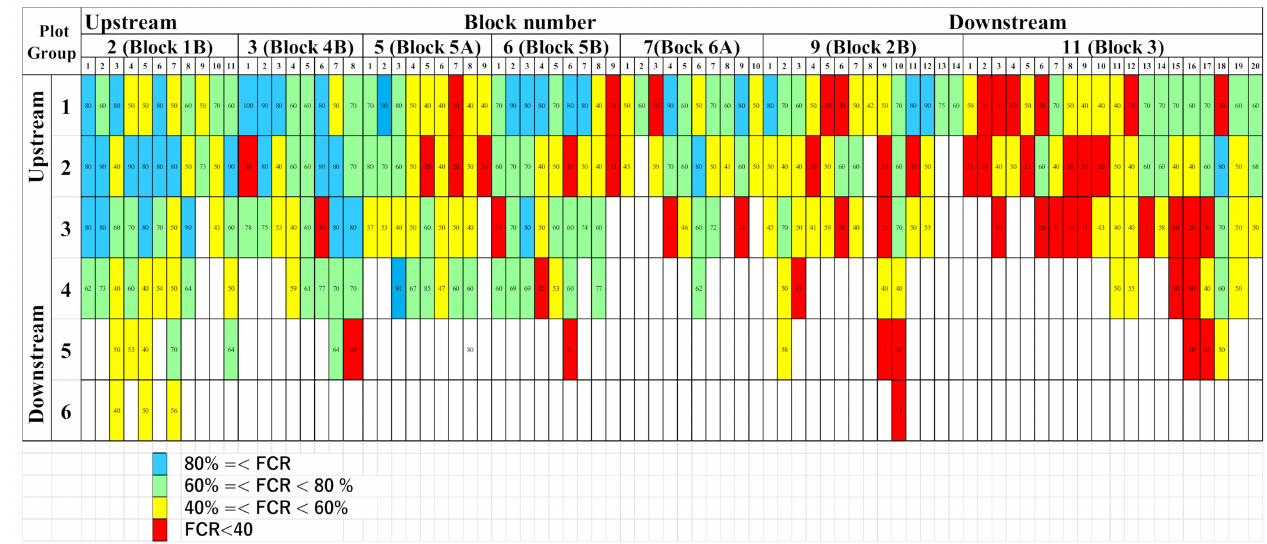
Figure 7. Water FCR distribution within the irrigation blocks.